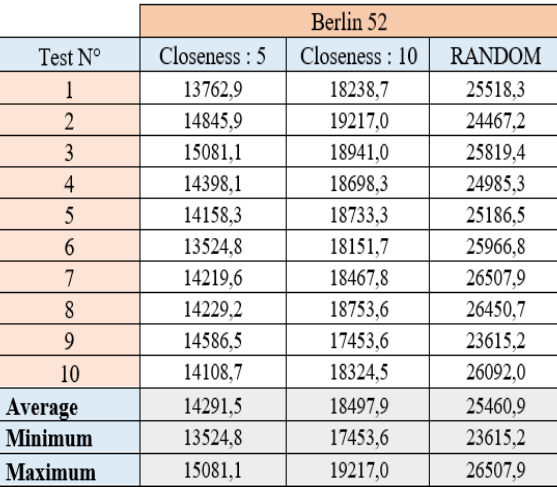
Table3: Summary of simulation results for the